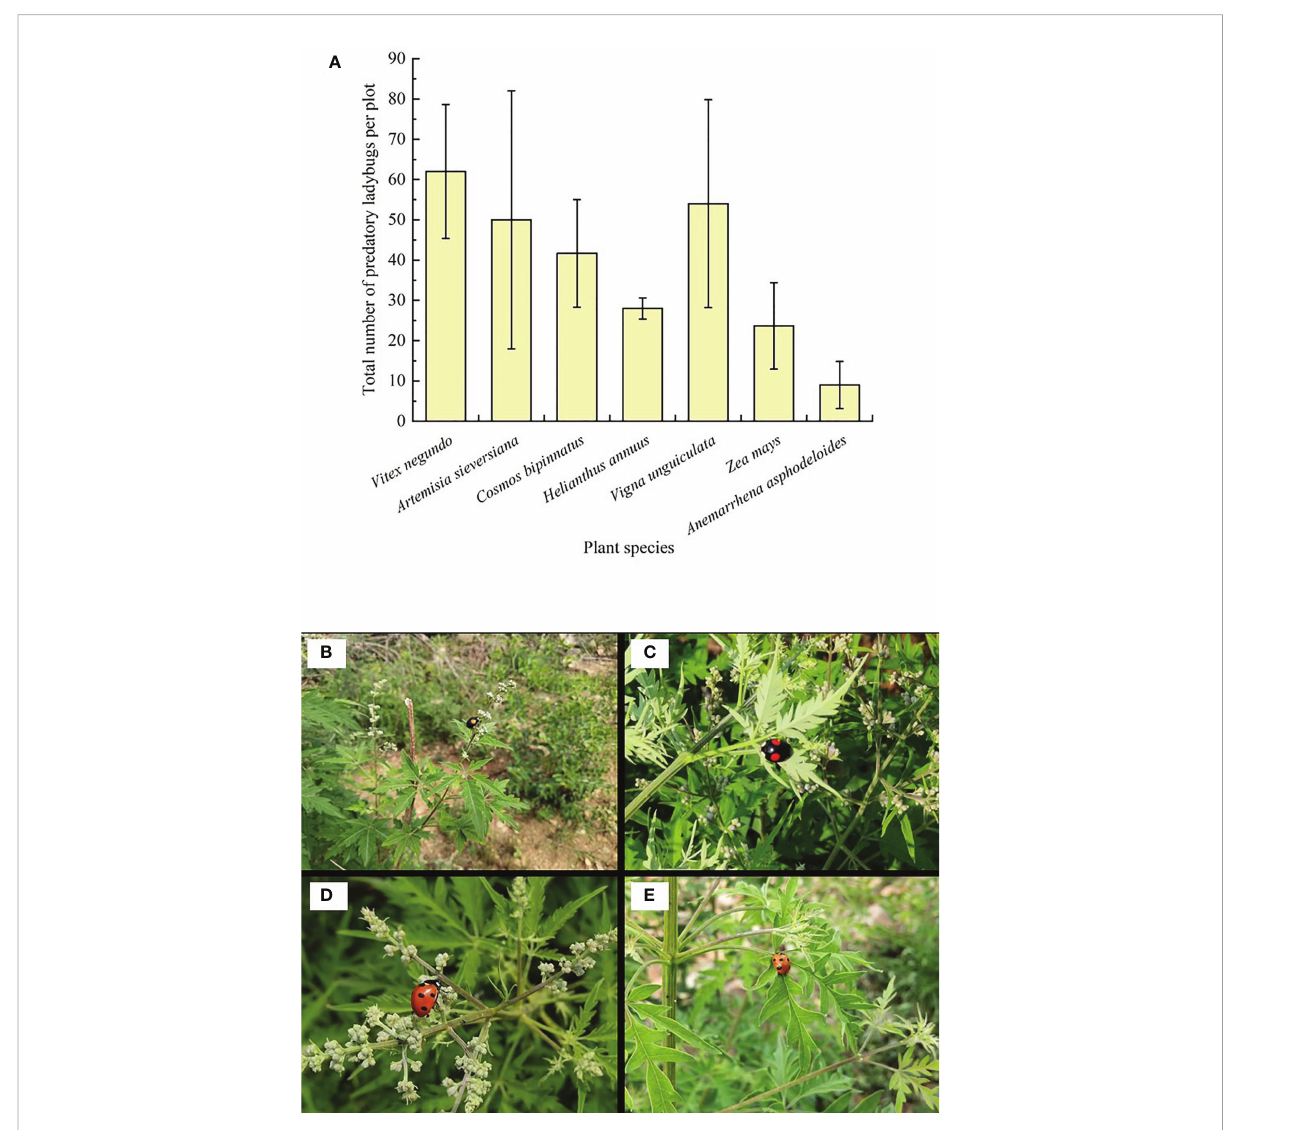
FIGURE 1 Abundance of predatory ladybugs on habitat plants and predatory ladybugs on Vitex negundo . Mean (± SE) per plot (A) , Harmonia axyridis (B, C) and Coccinella septempunctata (D, E) adults are visiting the fl owers and